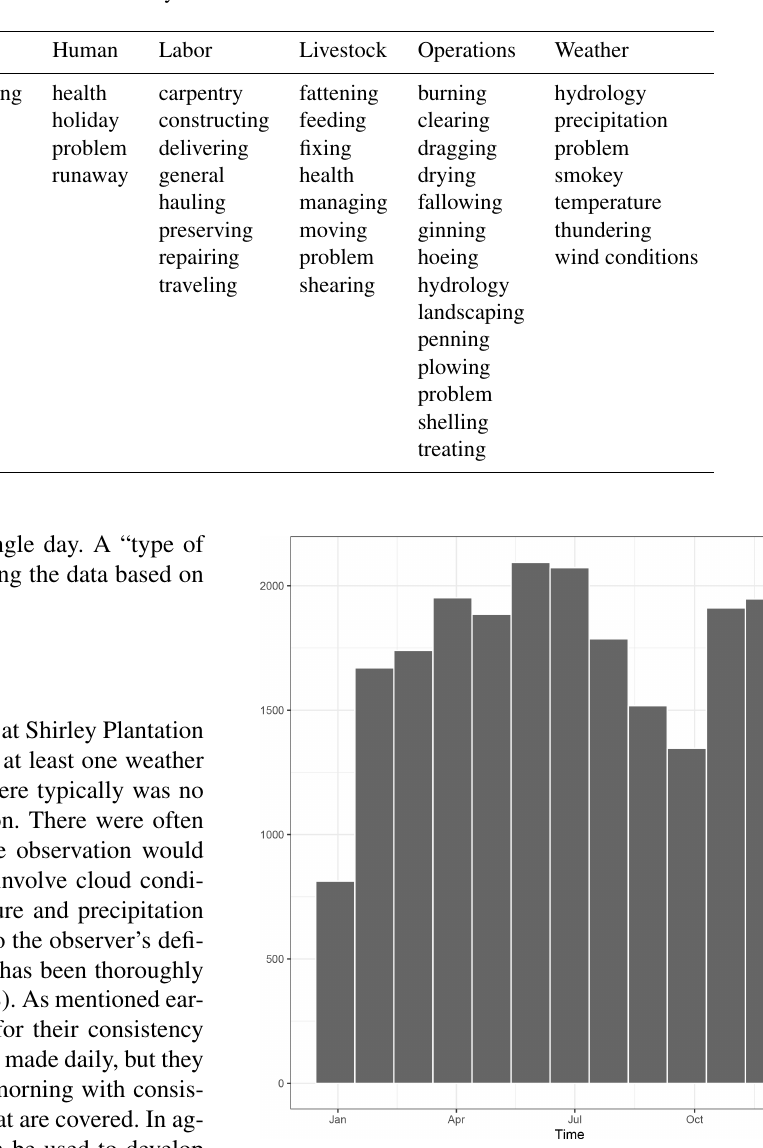
Figure 4. Number of database entries per month. Activity on the plantation increased over the growing season and then diminished over the fall and